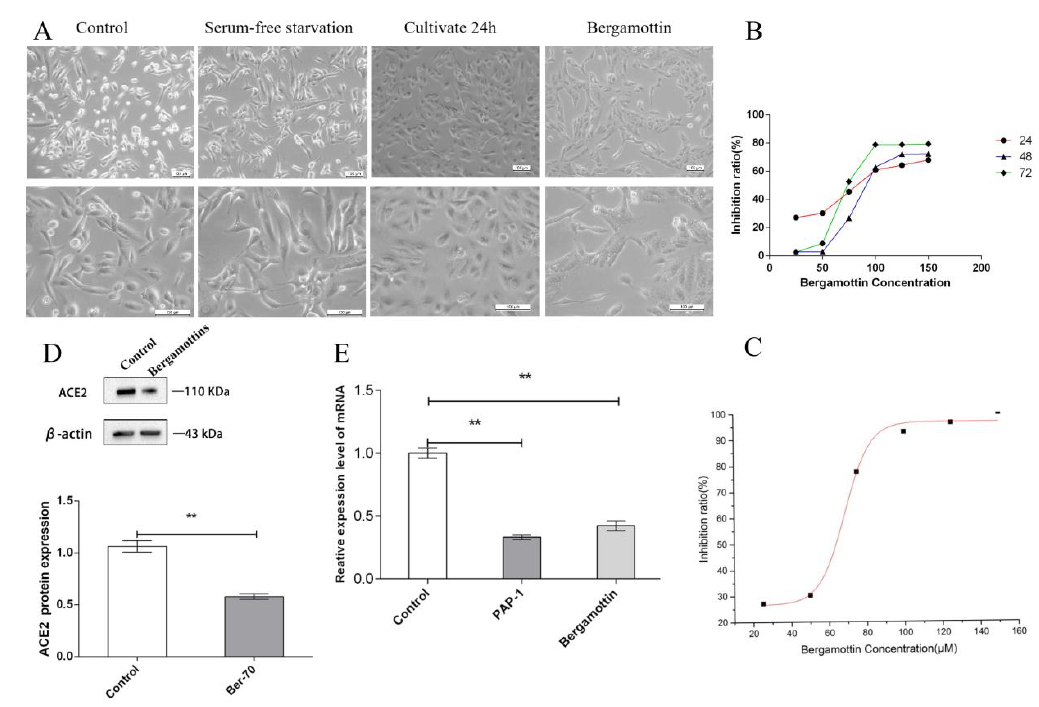
Figure 6. Effects of bergamottin viability of AT-II cells and cell morphology. ( A ) AT-II cells were treated with the indicated concentrations of bergamottin for 24 h with cell count ( × 100 and × 200). ( B ) Effects of bergamottin on viability of AT-II cells for 24, 48, and 72 h by CCK-8 kit, comparison of cell viability at 24 h of bergamottin with different concentrations. ( C ) After 24 h treatment of AT-II cells with bergamottin at 25, 50, 75, 100, and 150 µ M, cell viability (by CCK-8 assay, n = 5) of both cell types was inhibited in a concentration-dependent manner in accordance with the Hill equation: y = ax b /(c b + x b ). Accordingly, 70 µ M was chosen as the bergamottin dose for subsequent experiments. ( D ) Western blot detection of expression of ACE2 proteins in AT-II cells. Normalized to β -actin. ** p < 0.01 bergamottin vs. Control, ACE2 protein after administration of bergamottin were signifificantly lower than the control group, ( E ) mRNA expression levels of ACE2 relative to AT-II cells with bergamottin. The data in the figure was measured in the following manner: Unpaired data in compliance with normal distribution and homogeneity between two groups were compared using an unpaired t test. The experiment was independently repeated three times.